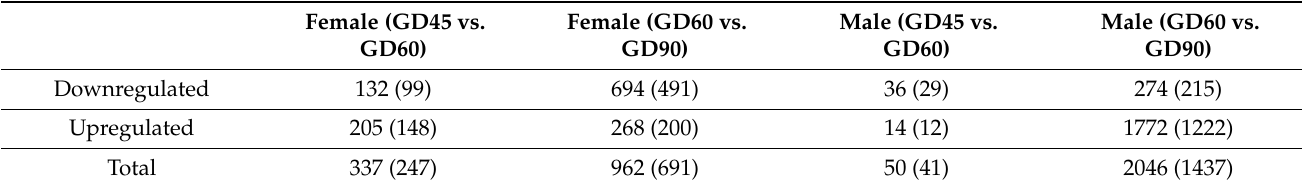
Table 2. Number of significantly differentially expressed exons in the developing fetal brain of male and female fetuses between GDs 45 vs. 60 and GDs 60 vs. 90. The number in the parenthesis represents the number of genes associated with the exons. Female (GD45